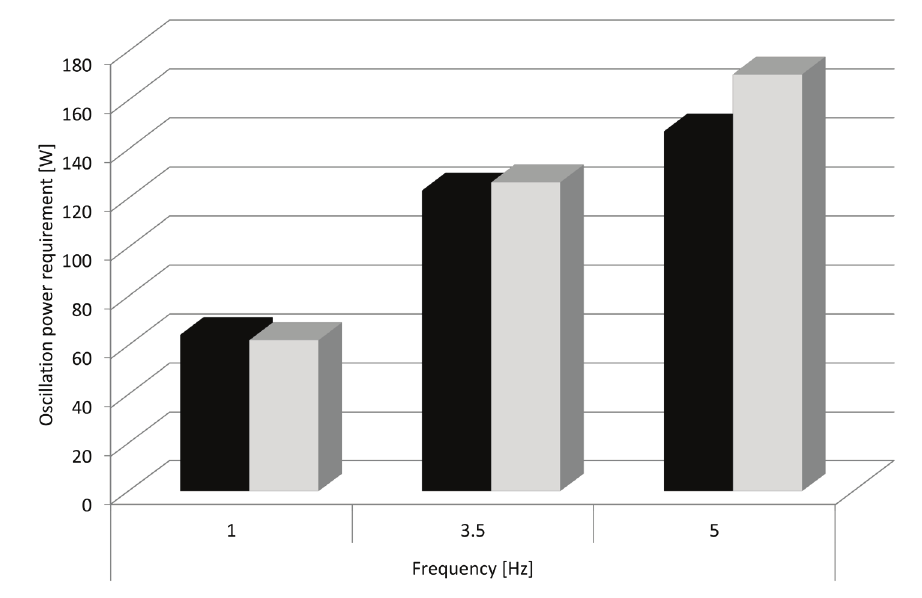
Fig. 4 – Effect of extended module length on the oscillatory power requirement (black column = one module; grey column = two modules) (10 % SL, α-cellulose,